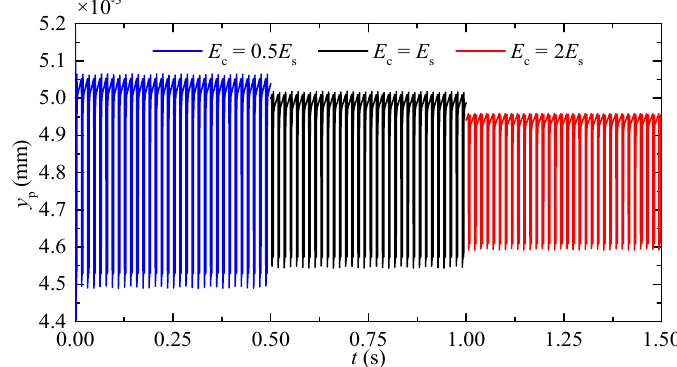
Figure 10. Vibration displacements along LOA under different coating elastic moduli.